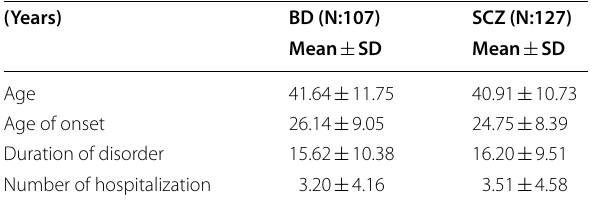
Table 1 The clinical characteristics of